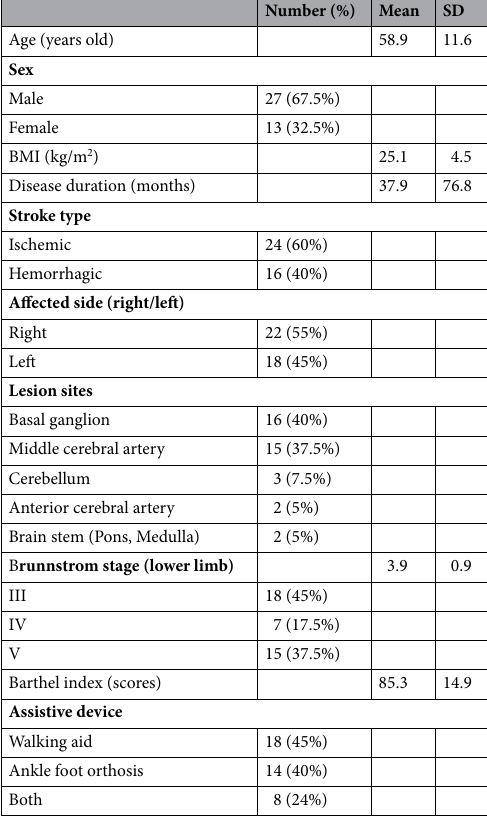
Table 2 shows the assessment of walk- ing ability and spasticity. The average score of TT was 21.1 ± 4.4, with sectional scores of balance (12.2 ± 2.7) and